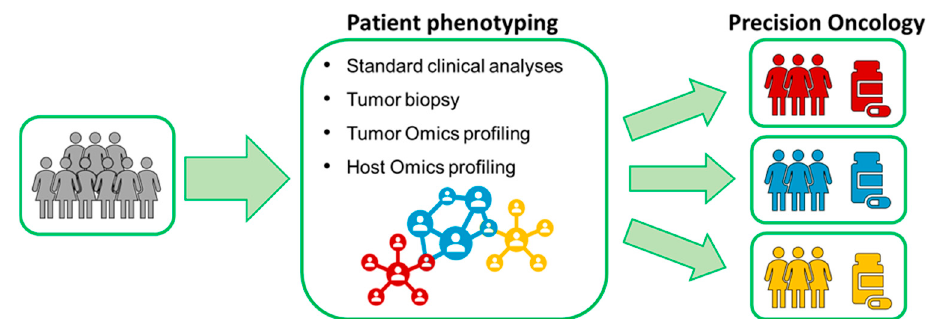
Figure 1. Precision oncology in a nutshell.